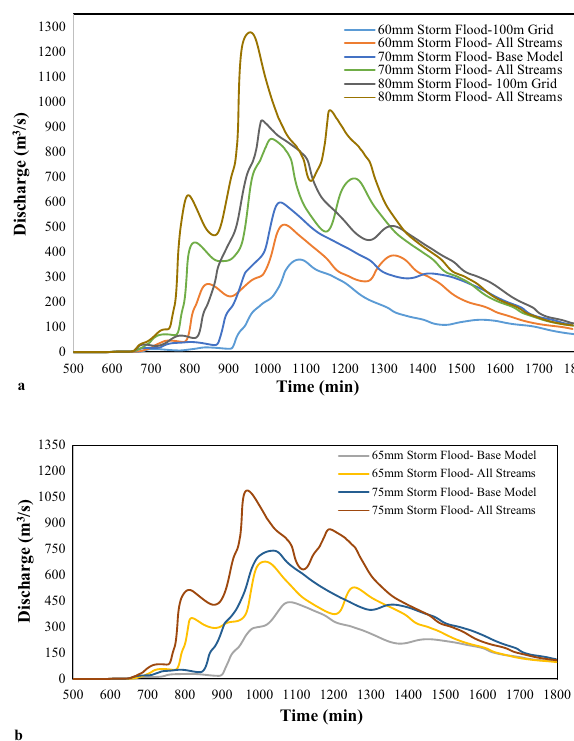
Fig. 24 a Flood hydrograph of 100 m grid cell size GSSHA model for three 24-h storm floods of 60, 70 and 80 mm compared with the corresponding hydrographs of the same GSSHA model including all waterways with a drainage area of larger than 5 km 2 . b Flood hydro- graph of 100 m grid cell size GSSHA model for three 24-h storm floods of 65 and 75 mm compared with the corresponding hydro- graphs of the same GSSHA model including all waterways with a drainage area of larger than 5 km